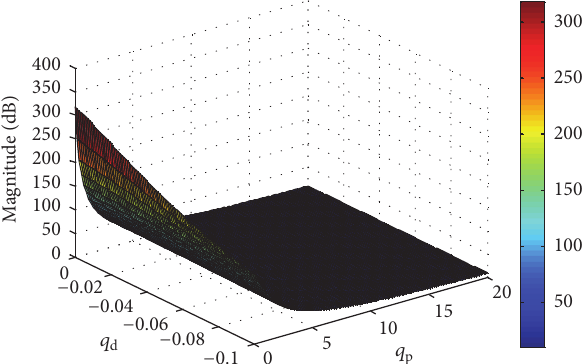
Figure 11: Standard deviation of contact force versus 𝑞 p and 𝑞 d